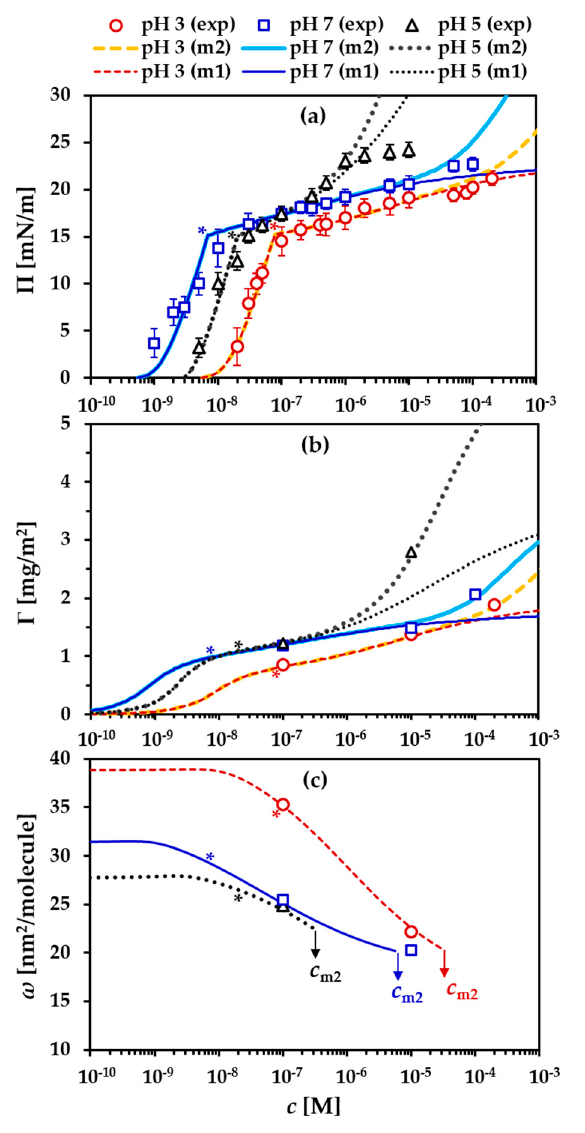
Figure 1. β -lactoglobulin (BLG) adsorption layers at the water/air interface at different bulk pH. ( a ) Surface pressure isotherms Π ( c ). ( b ) Adsorption isotherms Γ ( c ) (experimental data from [24]). ( c ) Protein concentration dependencies of the area per molecule ω ( c ) (experimental data from [24]); note that an ω ( c ) dependency describes only the primary monolayer, and it is independent of the formation of further sublayers (see details in the text). Symbols are experimental data (exp), and lines are best fits for one-layer (m1) and two-layer (m2) models; asterisks indicate Π *, Γ * and ω * at c *, and arrows in ( c ) indicate the onset of double layer formation at c m2 .